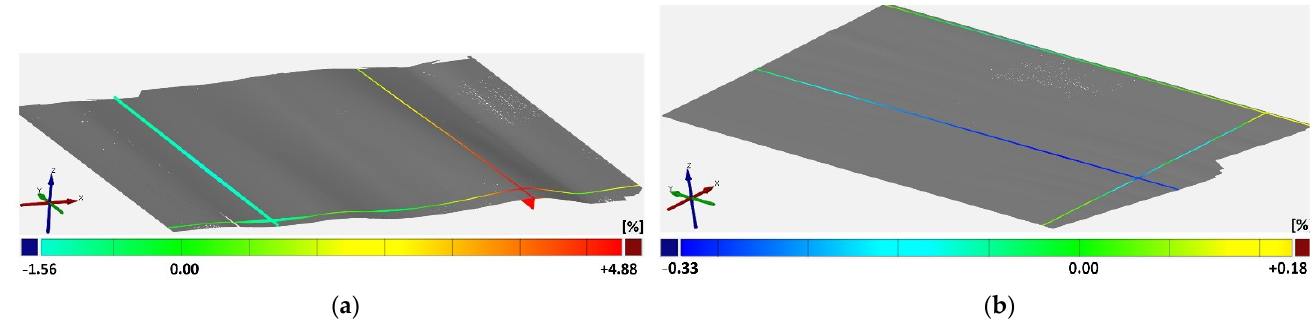
Figure 6. Geometric shape of calendered NMC811 (double-sided, low compaction rate): ( a ) with an uncoated collector (No. 8); ( b ) without an uncoated collector (No. 5).